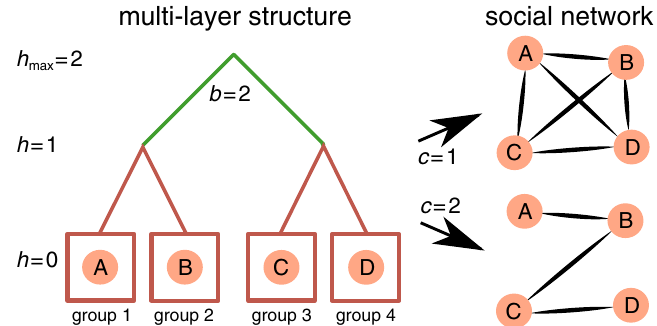
Figure 4. Multi-layer social model. The underlying multi-layer structure (left) defines the probability p � h ( i , j ) ∝ c − � h of forming connections between individuals i and j in the social network (right). If c = 1 , everyone interacts with everyone else leading to a fully connected network whereas for higher c , interactions between closer individuals (lower h ) are more common. For example, the distance (cid:31) h A , B = 1 and (cid:31) h A , D = 2 . With cost c = 1 , edges ( A , B ) and ( A , D ) are equally likely ( p 1 = p 2 ∝ 1 ), whereas with higher cost, e.g. c = 2 , edge ( A , B ) is more likely ( p 1 ∝ 1 / 2 ) to occur than edge ( A , D ) ( p 2 ∝ 1 / 4